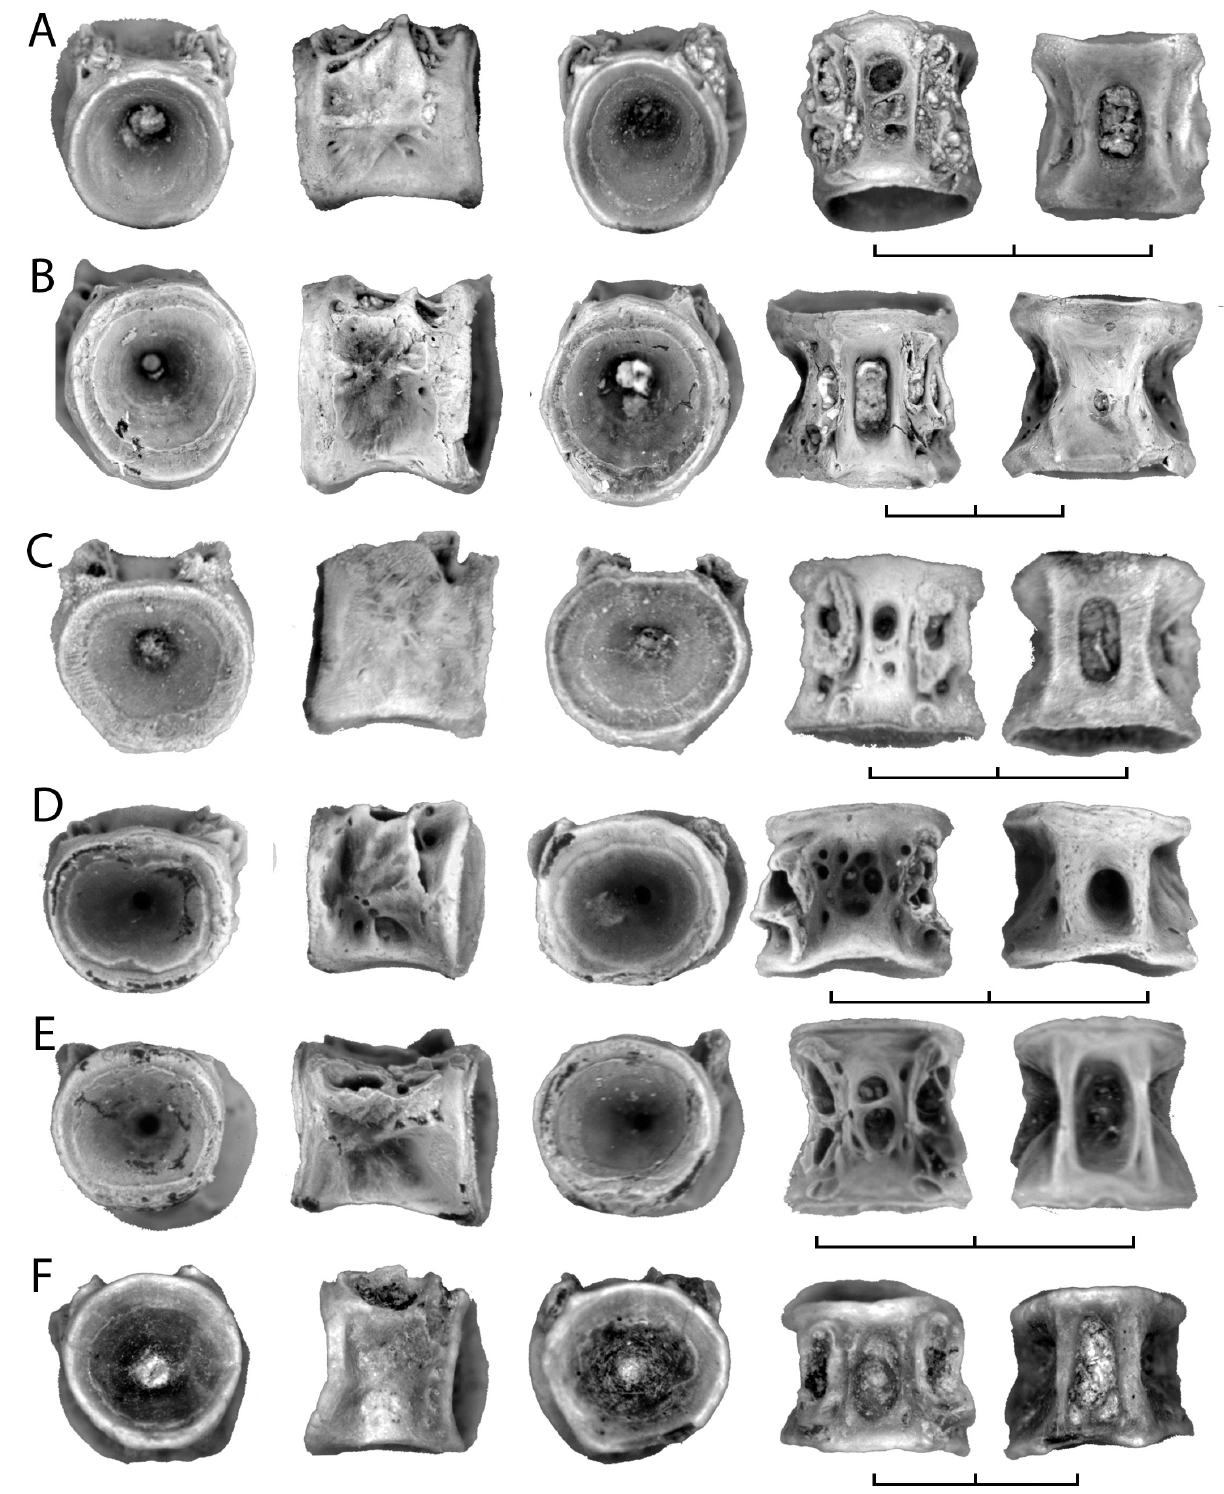
Figure 13. Centrum of morphotype BvarE, tentatively referred to Wilsonichthys , from the Milk River Formation, the late Campanian of Utah and Alberta, and the late Maastrichitan of Wyoming A – B) centra from the Milk River Formation, showing variation in the development of the mid-ventral pit: A, UALVP 48888; B, UALVP 48889. C) centrum from the late Campanian Kaiparowits Formation of Utah, OMNH 23786. D) centrum from the late Campanian Belly River Group of Alberta, TMP 95.182.50. E) centrum from the late Maastrichtian Hell Creek Formation of Montana, specimen UCMP 191697/V99369. F) cen - trum from the late Maastrichtian Lance Formation of Wyoming, UALVP 56054. Centra shown in anterior, left lateral, poster - ior, dorsal and ventral views. C from Brinkman et al. (2013: fig. 10.27A). Scale bar equals 2